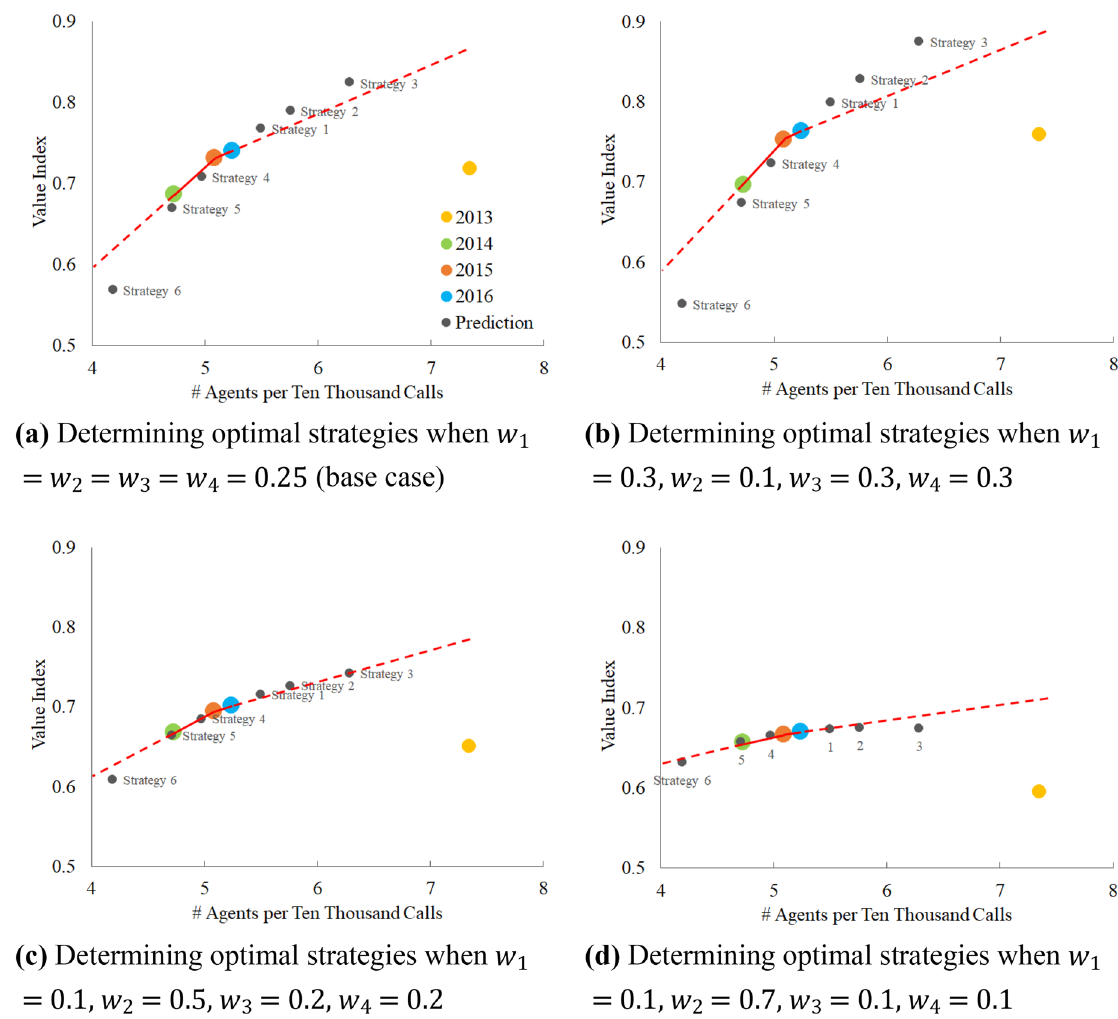
Fig. 4 Using Efficient Frontier to evaluate resource planning strategies given weighting